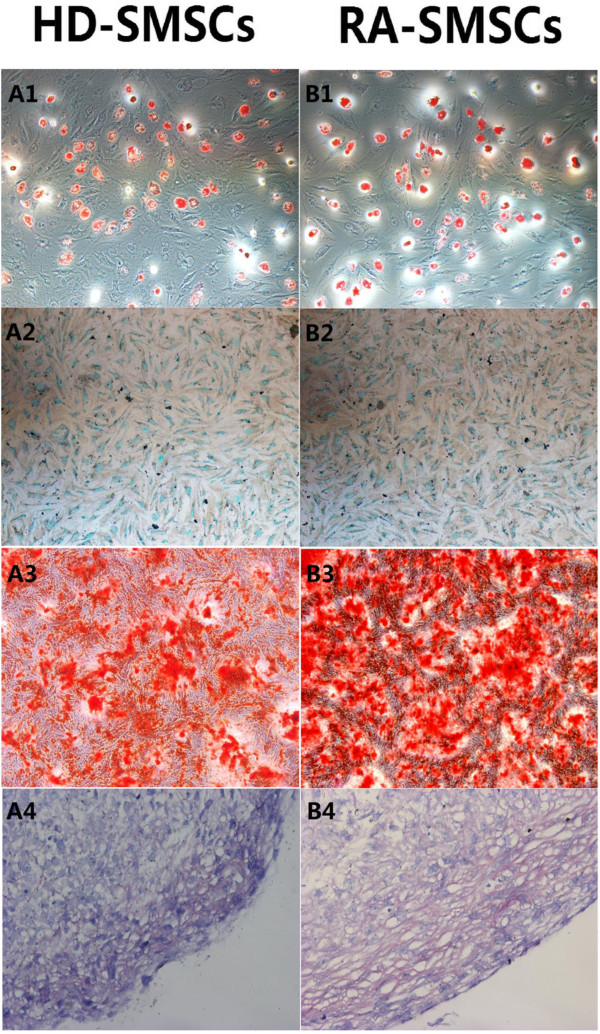
Synovium-derived mesenchymal stem cells (SMSCs) triple differentiation potentials from healthy donors and patients with rheumatoid arthritis (RA). (A, B) Morphologic characteristics of SMSCs for adipogenic, osteogenic, and chondrogenic differentiation evaluated with the inverted phase-contrast microscope; SMSCs from RA patients (RA-SMSCs) have the same morphologic properties as SMSCs from healthy donors (HD-SMSCs). Adipocytes were filled with many fat vacuoles, and Red Oil O was used to stain the fat vacuoles of adipocytes (A1, B1: ×100). Osteocytes were stained for alkaline phosphatase (ALP) with the Cell ALP assay (A2, B2: ×100) and for calcium deposition by using alizarin red-S (A3, B3: ×100). Chondroblast differentiation from SMSCs was displayed as cartilage-specific metachromasia with alcian blue (A4, B4: ×100).